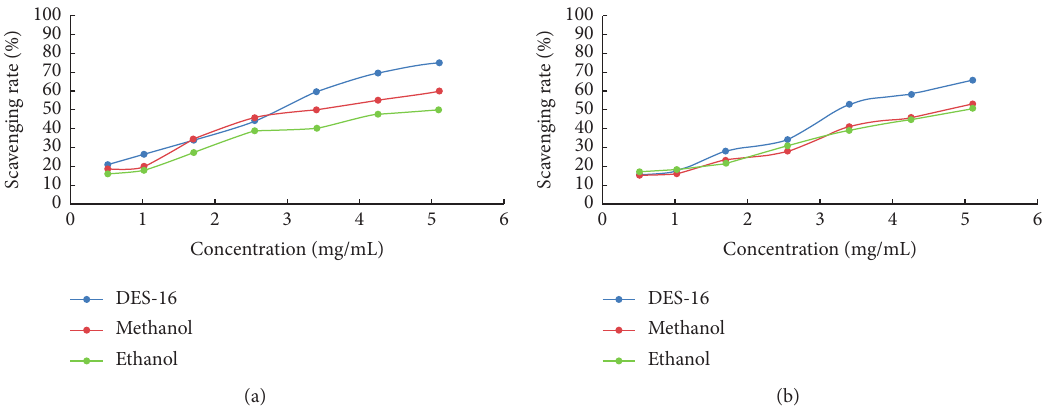
Figure 5: Scavenging rates of different concentrations of SR extracts on DPPH anion (a) and ABTS cation